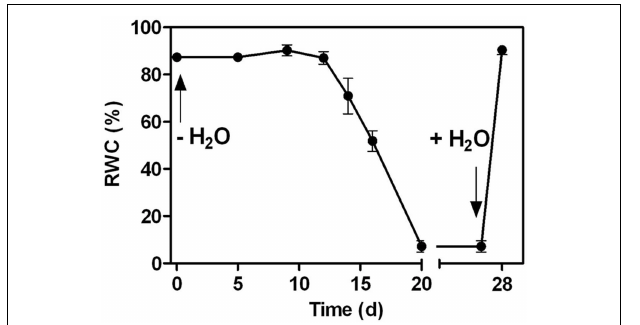
FIGURE 1 | Changes in the relative water content (RWC) in the leaves of C. plantagineum plants subjected to a 20 d water deficit stress. Plants were then held in a dried state for 7d and water deficit was alleviated by re-watering the plants. Error bars indicate the standard error between the mean of six replicates.